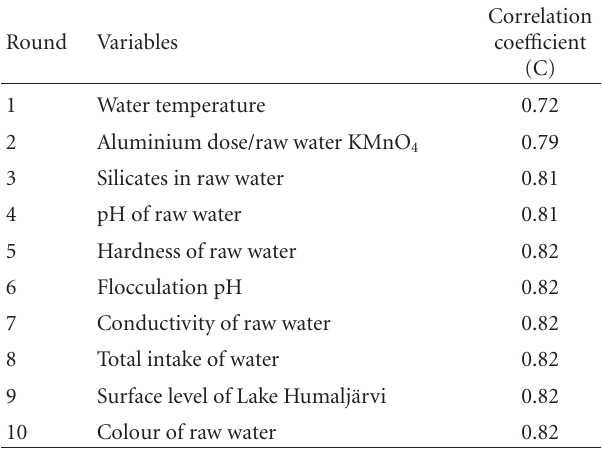
Table 5: Variables selected for residual aluminium using multiple linear regression (MLR).